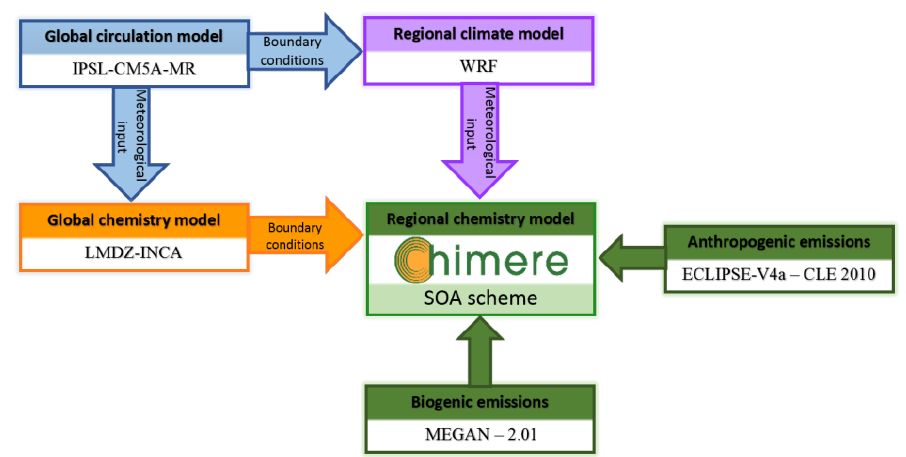
Figure 1. Simulation chain used for this study: the focus of this work is the SOA scheme inside the regional chemistry-transport model.